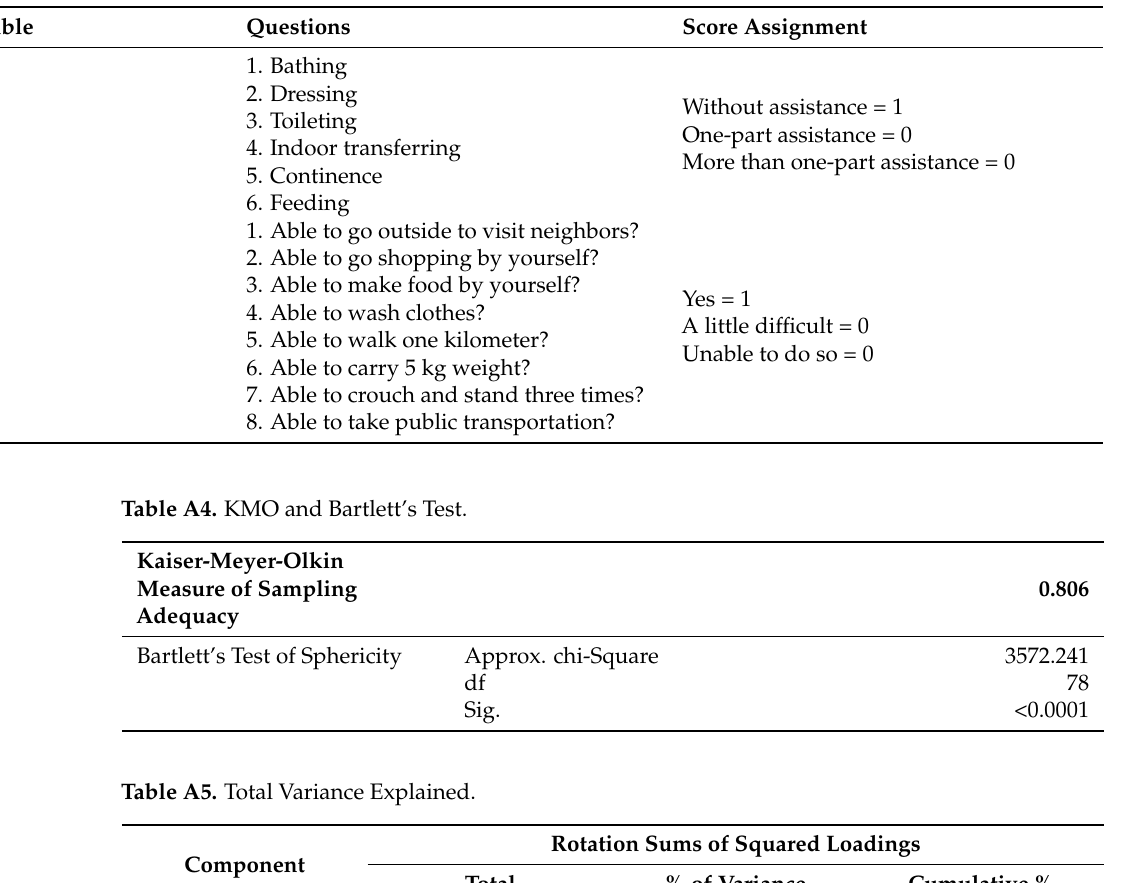
Table A3. Definition and score of body function.